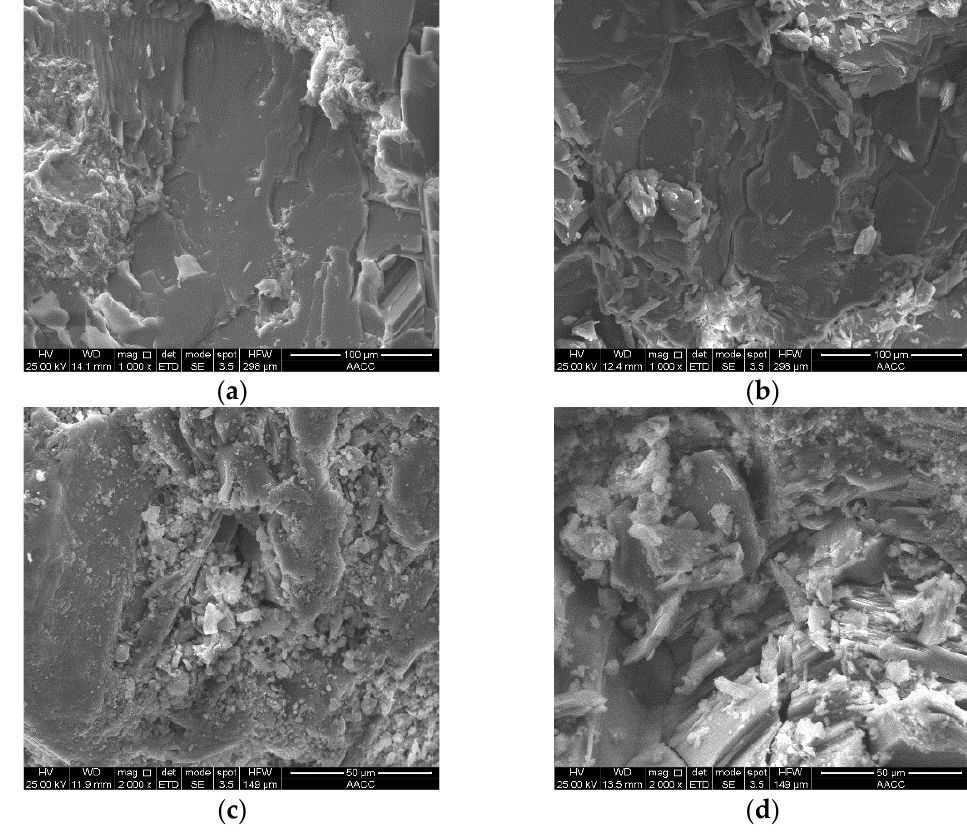
Figure 4. SEM images of the rock samples with different water immersion times: ( a ) Natural, ( b ) 7 days, ( c ) 15 days, and ( d ) 30 days ( b ) 7 days, ( c ) 15 days, and ( d ) 30